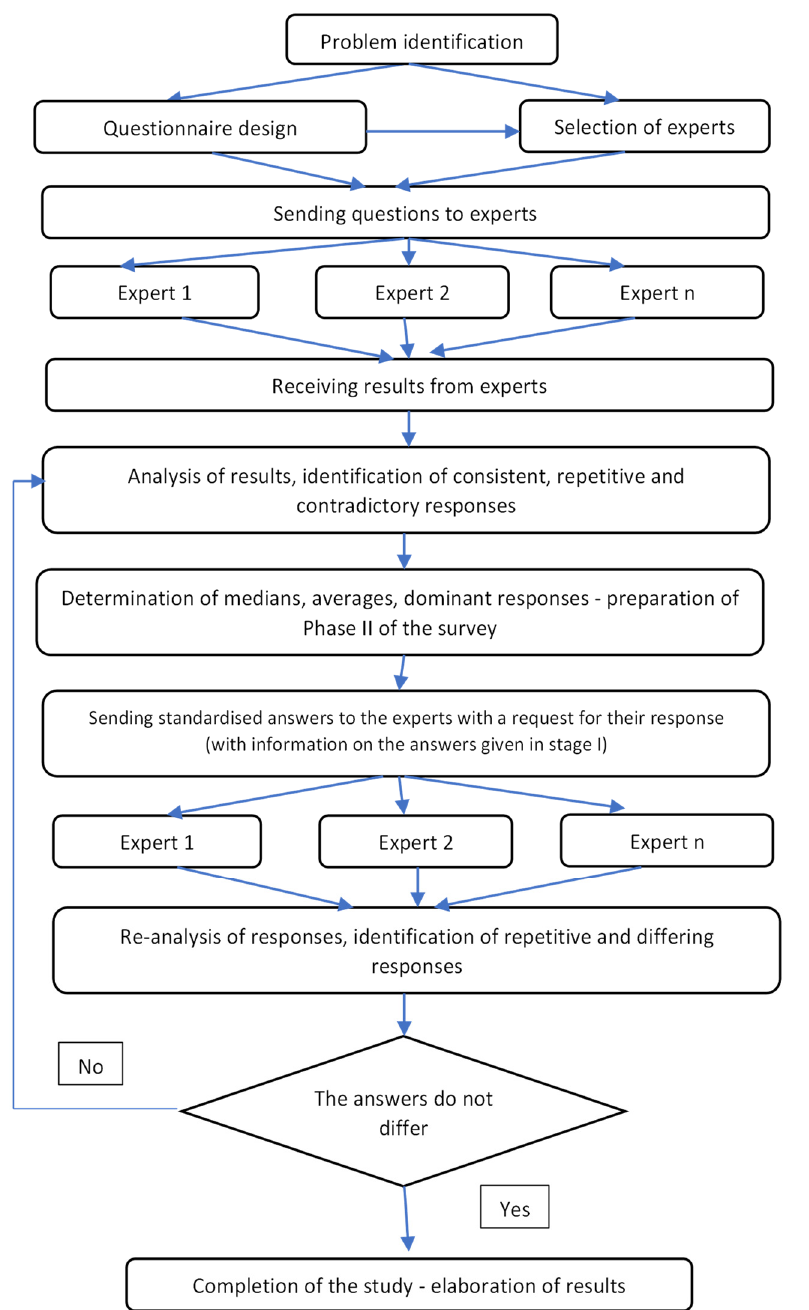
Figure 2. Simplified algorithm of the expert study carried out. Source: own elaborations.